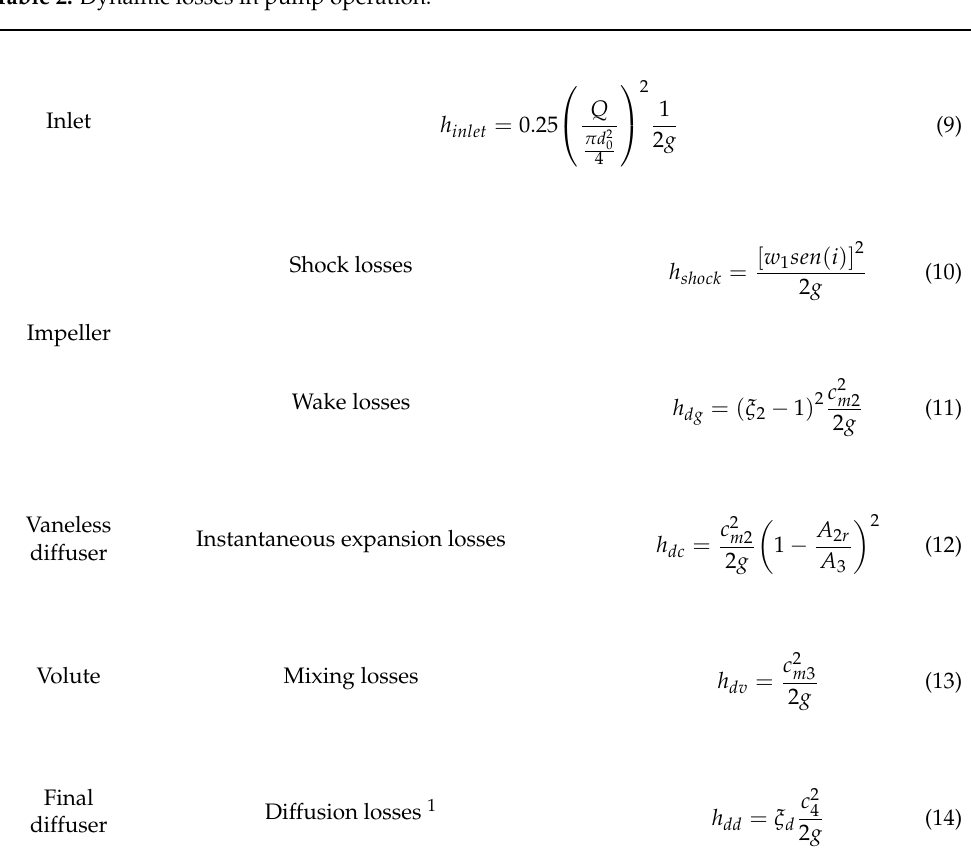
Table 2. Dynamic losses in pump operation.